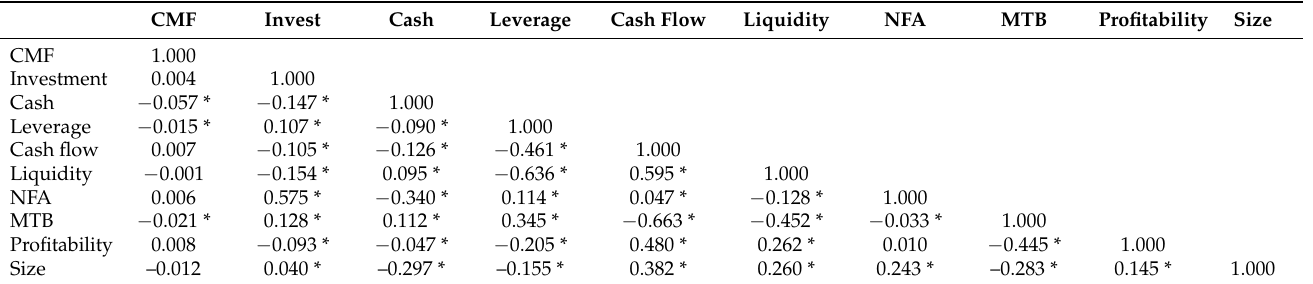
Table 4. Correlations.